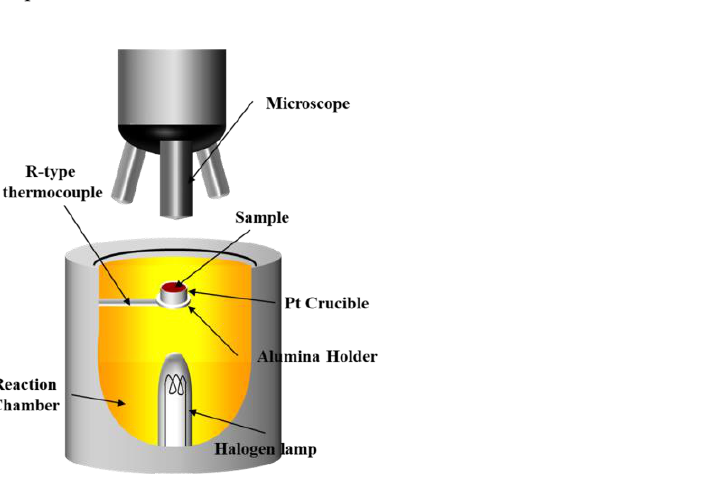
Figure 1. Temperature profiles of the preparation procedure: ( a ) equilibrium samples, ( b ) metastable samples.